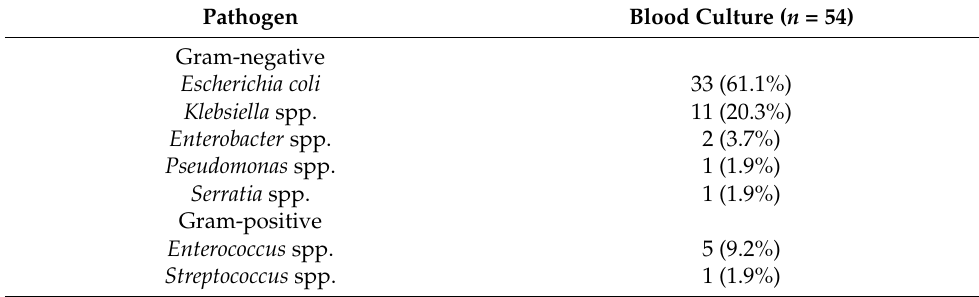
Table 2. Fifty-four isolated pathogens from blood culture in 50 patients with acute cholangitis. Pathogen Blood Culture ( n = 54)